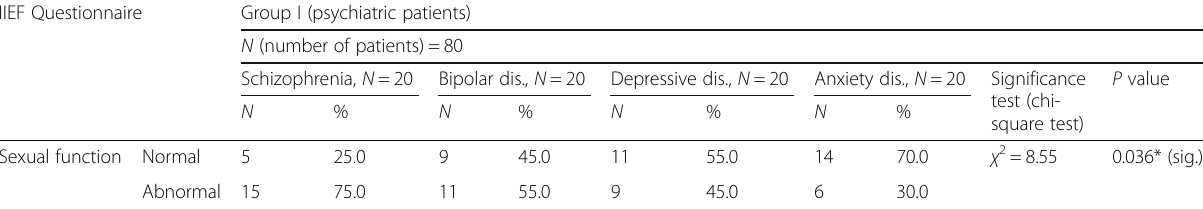
Table 3 Sexual dysfunctions among patients of group I (psychiatric patients)